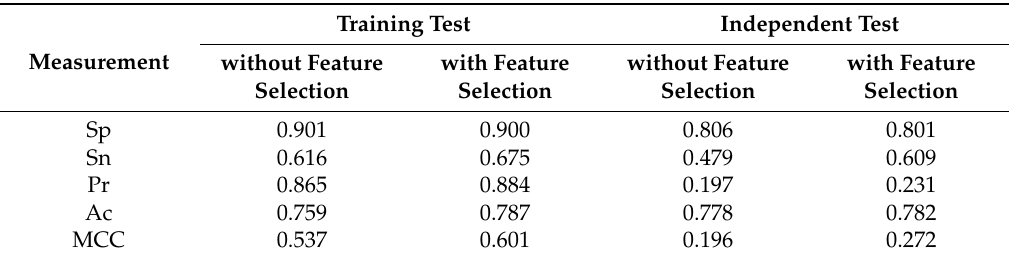
Table 2. NTyroSite prediction performances for without and with features